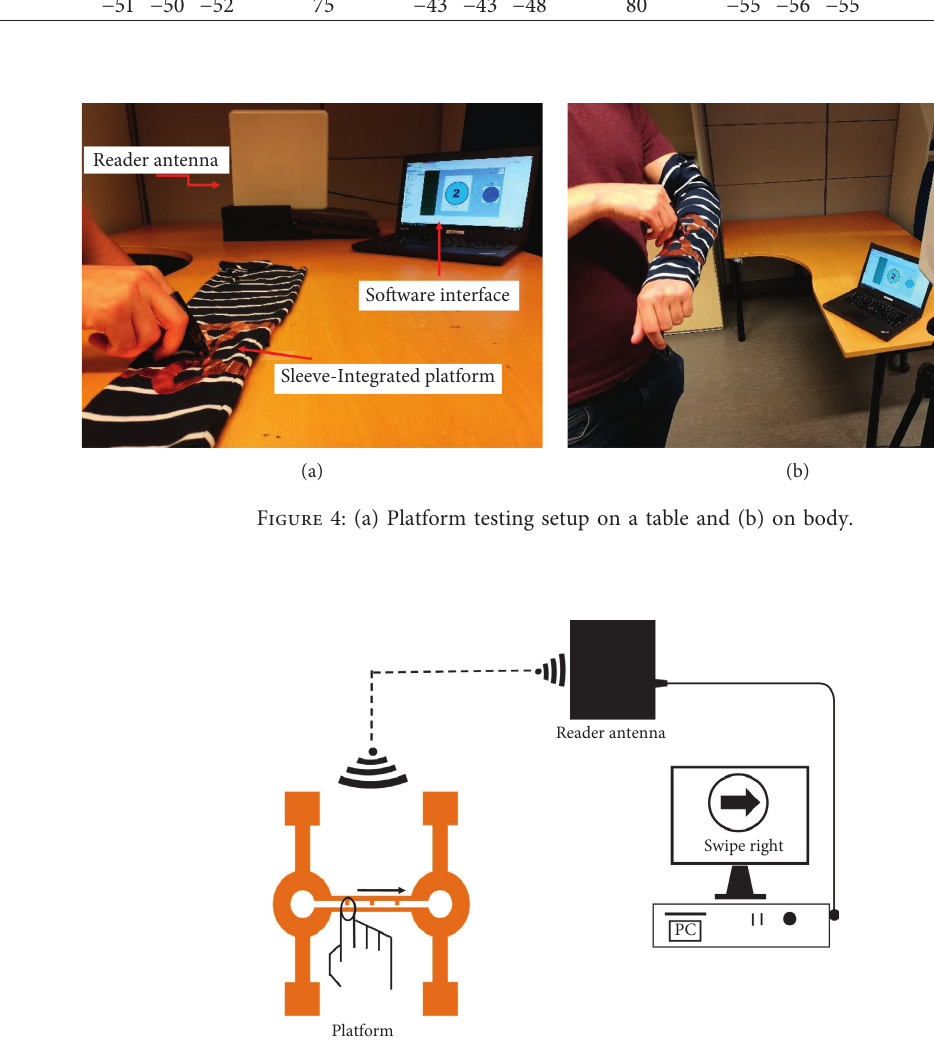
Figure 5: The operating principle of ClothFace